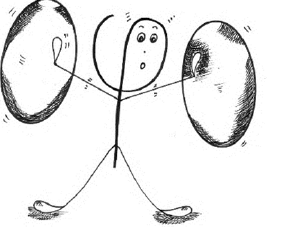
Figure 8. Adjusted quasi-phi-functions for appropriate geometries are used for describing non- overlapping of components with minimal allowable distances ( left ) and phi-functions are applied for containment of components in the cuboidal container ( right ).